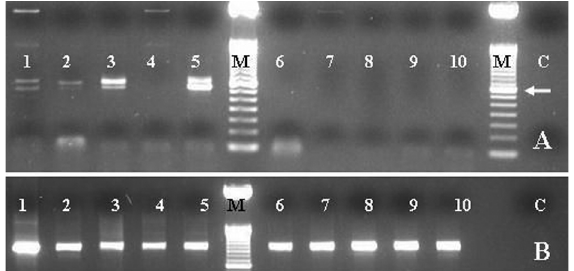
Figure 3 - Expression of KLK2 and β -2 microglobulin ( β -2M) mRNA in peripheral blood of prostate cancer and benign prostatic hyperplasia (BPH) patients. A: semi-nested RT-PCR for KLK2 gene expression. Col- umns 1 to 5 represent prostate cancer patients, and columns 6 to 10 are BPH patients. M = 50-bp ladder (molecular marker) and the arrow a 350-bp marker. C = negative control reaction (without template). The KLK2 fragments sizes were 324 and 361bp. B: RT-PCR reaction for the β -2M gene as a positive control for each sample, generating a 534 bp frag-